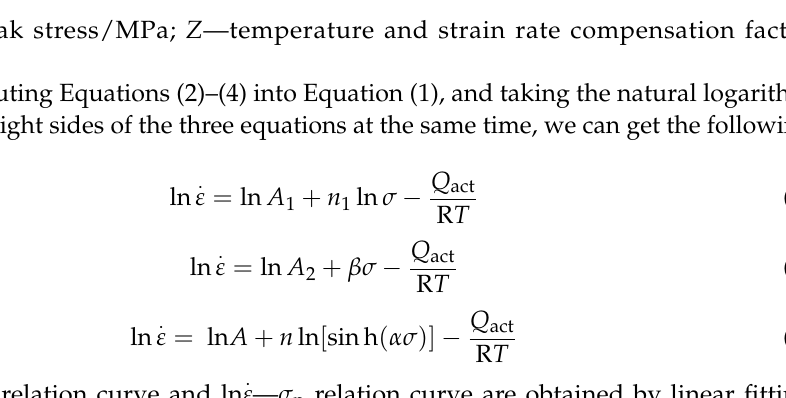
. ε —ln σ p relation curve and ln ln method for Equations (6)–(8), respectively, as shown in Figure 5a,b. According to the mean value of linear fitting slope of ln